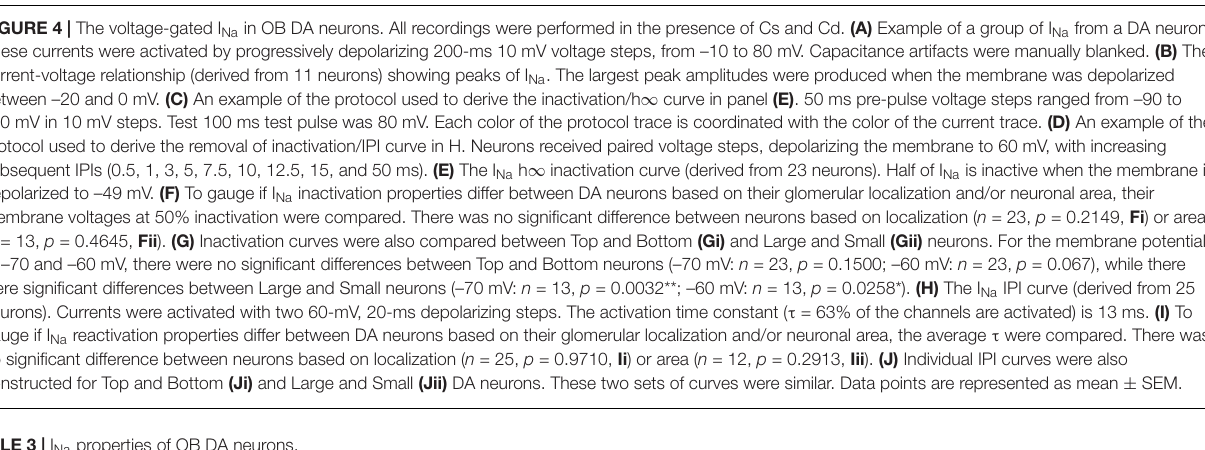
TABLE 3 | I Na properties of OB DA neurons. Top Bottom Large Small